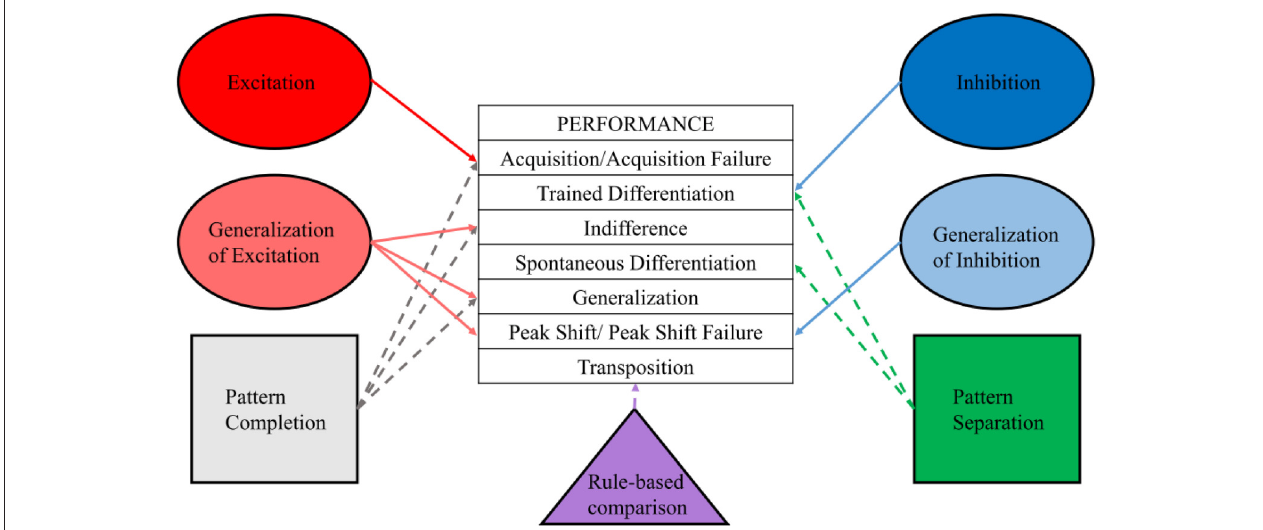
FIGURE 1 | Performance categories and underlying processes. Differentiating procedure, performance, and process, and assigning a particular process or processes to each observed behavior will aid in interpretation of results and development of new tests of current